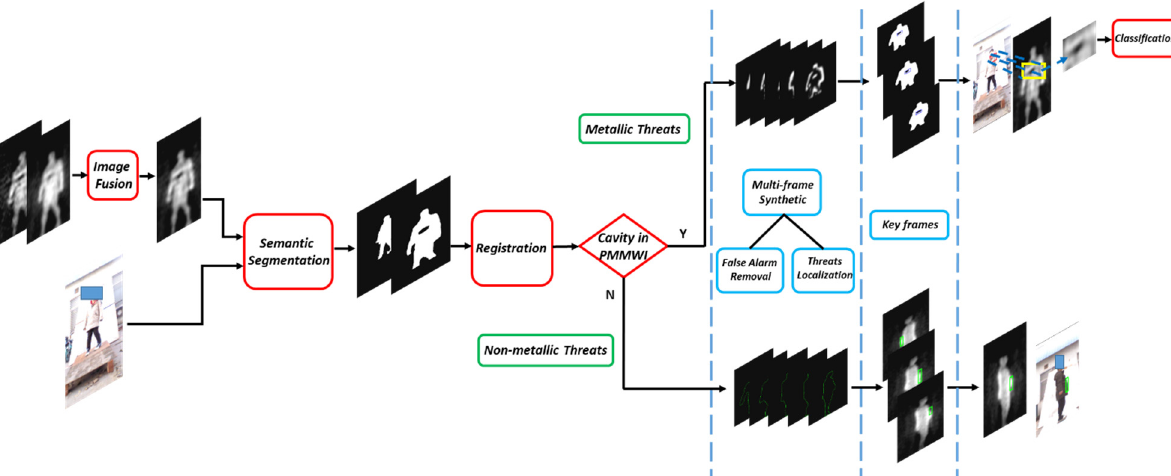
Figure 2. The flow diagram of the proposed solution. The detection process consists of 4 stages: First, analog and digital PMMWIs are fused to obtain high-quality PMMWI. Then the fused PMMWI and VI are segmented to extract human body and threats. The size of human body in the segmented images is adjusted to similar scale through registration network. In the comprehensive analysis stage, the detection is divided into two branches: metallic threats and non-metallic threats. Each branch performs detection on single frame, and then the proposed multi-frame synthesis strategy is applied on every 5 consecutive frames to produce a key frame. Finally, the IOU between two areas is calculated in key frames for each person and select the largest one as the finally result. The metallic threats will further to be identified by the classification network.